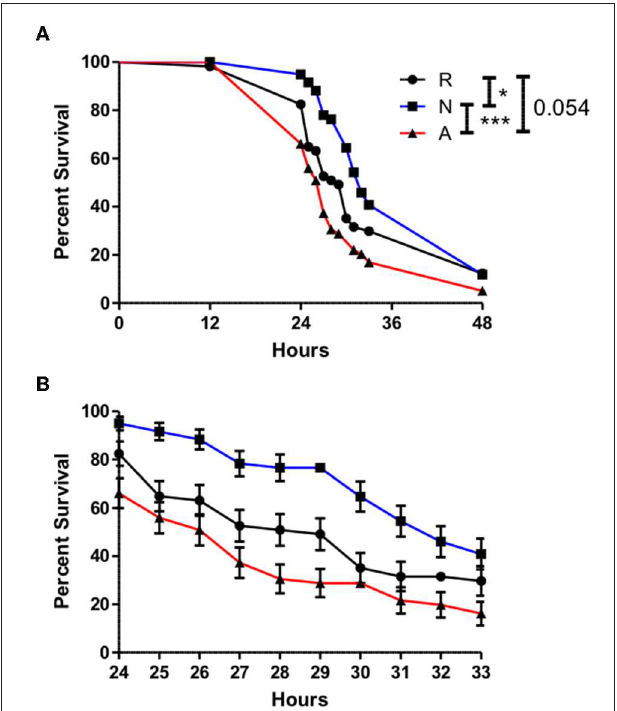
FIGURE 7 | The onset of mortality evoked by Photorhabdus luminescens infection is significantly advanced by Heterorhabditis bacteriophora nematode Excreted/Secreted activated products, but delayed by non-activated products. Adult Drosophila melanogaster were injected with 69.0 nl of a 1:4 mixture of OD 0.4 P. luminescens bacteria and activated ES products (A), non-activated ES products (N), or Ringer’s buffer (R), conveying 310 IJ equivalents of ES products and 50 CFUs of Photorhabdus . Survival was observed at 12h and then every hour after 24h until 33h in order to capture the majority of mortality events at a higher resolution. A final time point was assessed at 48h (A) . Mortality in injected flies between 24 and 36h is shown in (B) . Curves depict average values collected over three trials of 20 flies, 10 males, and 10 females, per treatment (* p < 0.05, *** p < 0.001).